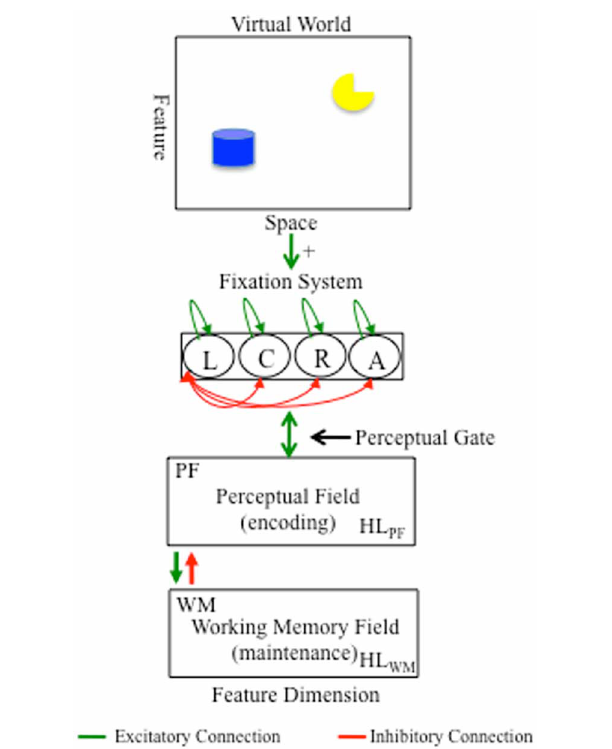
FIGURE 1 | DNF model architecture. At the top is a virtual world at which the model looks. The virtual world consists of two objects at left and right locations distributed over a continuous feature dimension (e.g., color). The presence of items at left and right locations bias the fixation system to look at those locations (see green arrow from space to fixation system). The fixation system interacts in a winner-take-all fashion such that fixating a location suppresses fixation to all other locations (see red arrows between nodes). Fixating a location acts like a perceptual gate into the cognitive system, which consists of a perceptual field (PF) and working memory (WM) field. PF and WM are reciprocally coupled to a shared layer of inhibitory interneurons (Inhib; not show). Activity in PF supports fixation (green bi-directional arrow between PF and fixation). Activity in WM suppresses PF via a strongly tuned connection from WM to Inhib (red arrow from WM to PF). Activity in PF and WM are influenced by activity in Hebbian layers, HL PF and HL WM , respectively, which accumulates over learning and facilitates encoding in PF and memory formation in